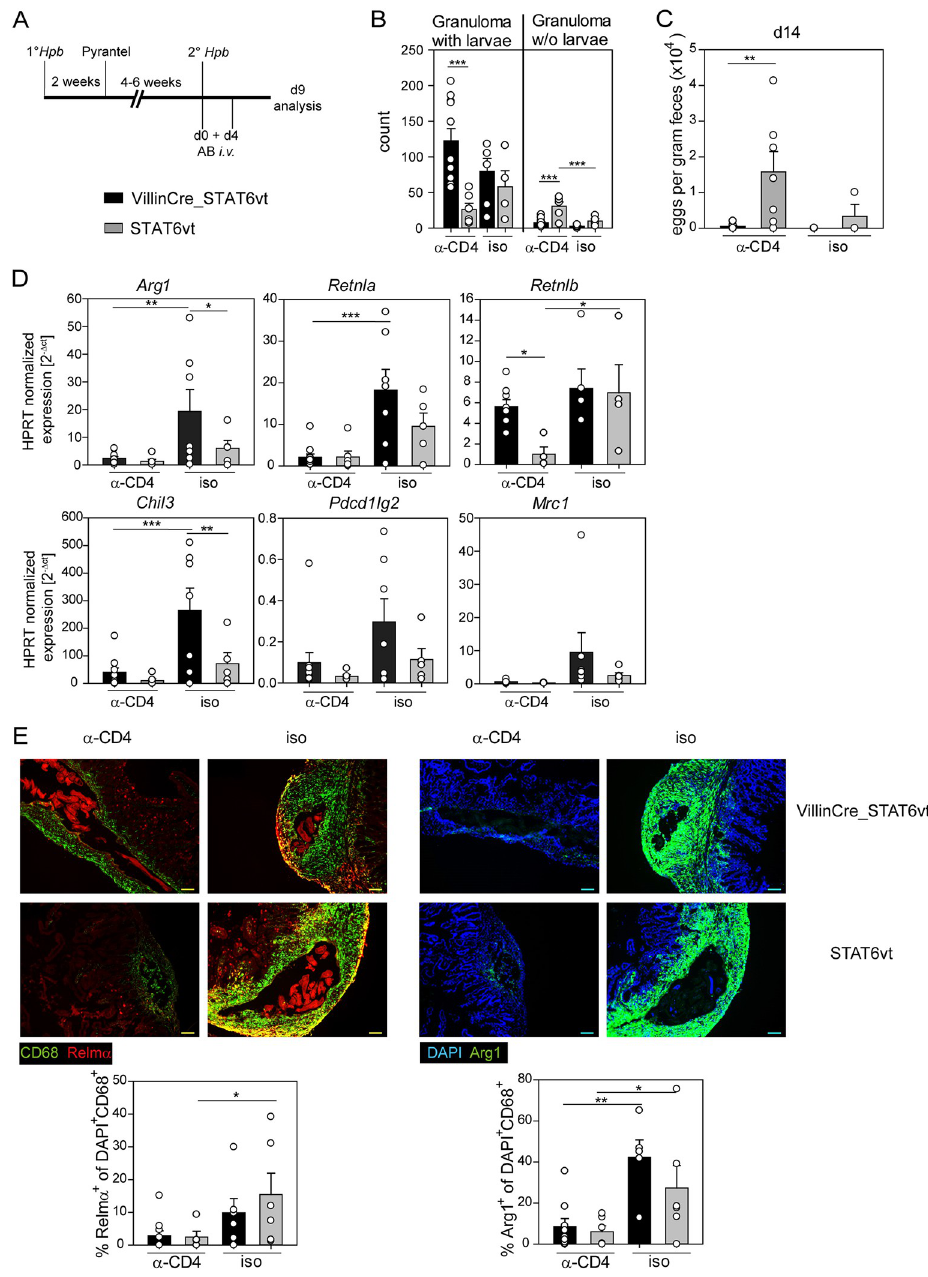
Fig 4. Activated STAT6 in intestinal epithelial cells is sufficient for larval trapping in the absence of CD4 + T cells. A) Schematic timeline for the CD4 depletion experiment performed with mice with constitutively active STAT6 in IECs (VillinCre_STAT6vt) and Cre - littermate controls (STAT6vt): Primary Hpb infection was cleared by oral gavage with twice 1 mg Pyrantel pamoate per mouse. 4–6 weeks later, mice were secondarily infected with Hpb and anti-CD4 or isotype antibody (AB) was injected i . v . on day 0 and 4 of secondary infection. B) Number of counted granuloma with or without (w/o) larvae in the submucosa on day 9 or 10 after secondary Hpb infection. Bars show mean count + SEM of four to eleven mice per group from two independent experiments. C) Eggs per gram feces counted on day 14 after secondary Hpb infection. Data show mean count + SEM of three to seven mice per group from two independent experiments. D) Relative expression of Arg1 , Retnla , Retnlb , Chil3 , Pdcd1lg2 , and Mrc1 , calculated by normalisation to Hprt . Bars show mean + SEM of four to eleven mice per group from two independent experiments. E) Histological staining and quantification of Relm- α (red) and CD68 (green) in tissue sections from small intestine day 9 after secondary Hpb infection in the left panel and for DAPI (blue) and Arg1 (green) in the right panel. Mean + SEM of percentage of Relm- α + or Arg1 + of DAPI + CD68 + cells, respectively. Representative picture for one mouse per